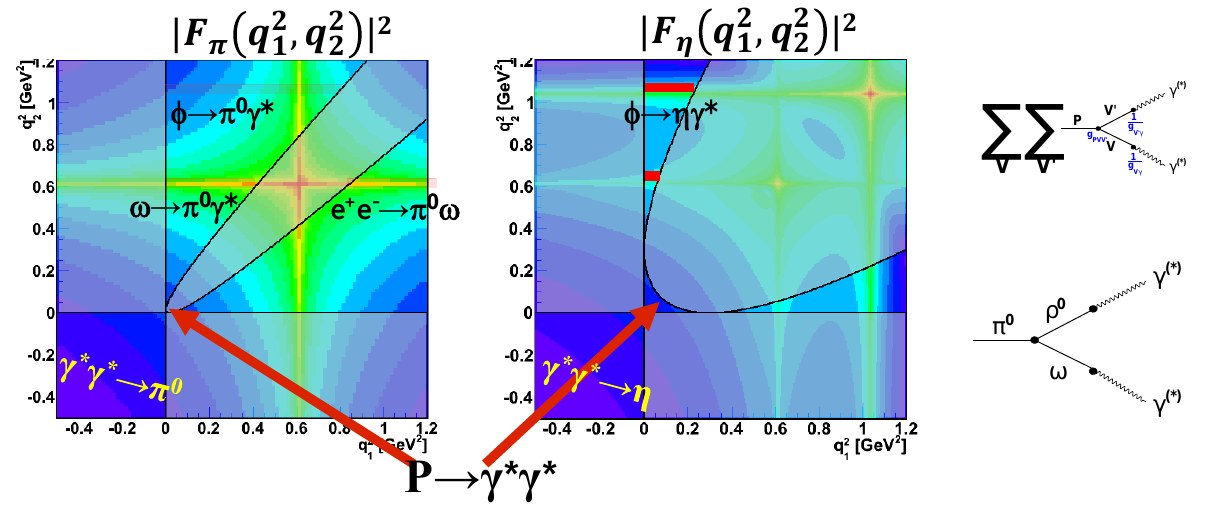
Figure 2. Kinematical regions of the π 0 and η TFFs as function of the photon virtualities q 2 coupling of photons to vector mesons according to the simplest version of the Vector Meson Dominance model (diagrams to the left). The greyish regions top left, bottom right and inside of the hyperbola are not experimentally